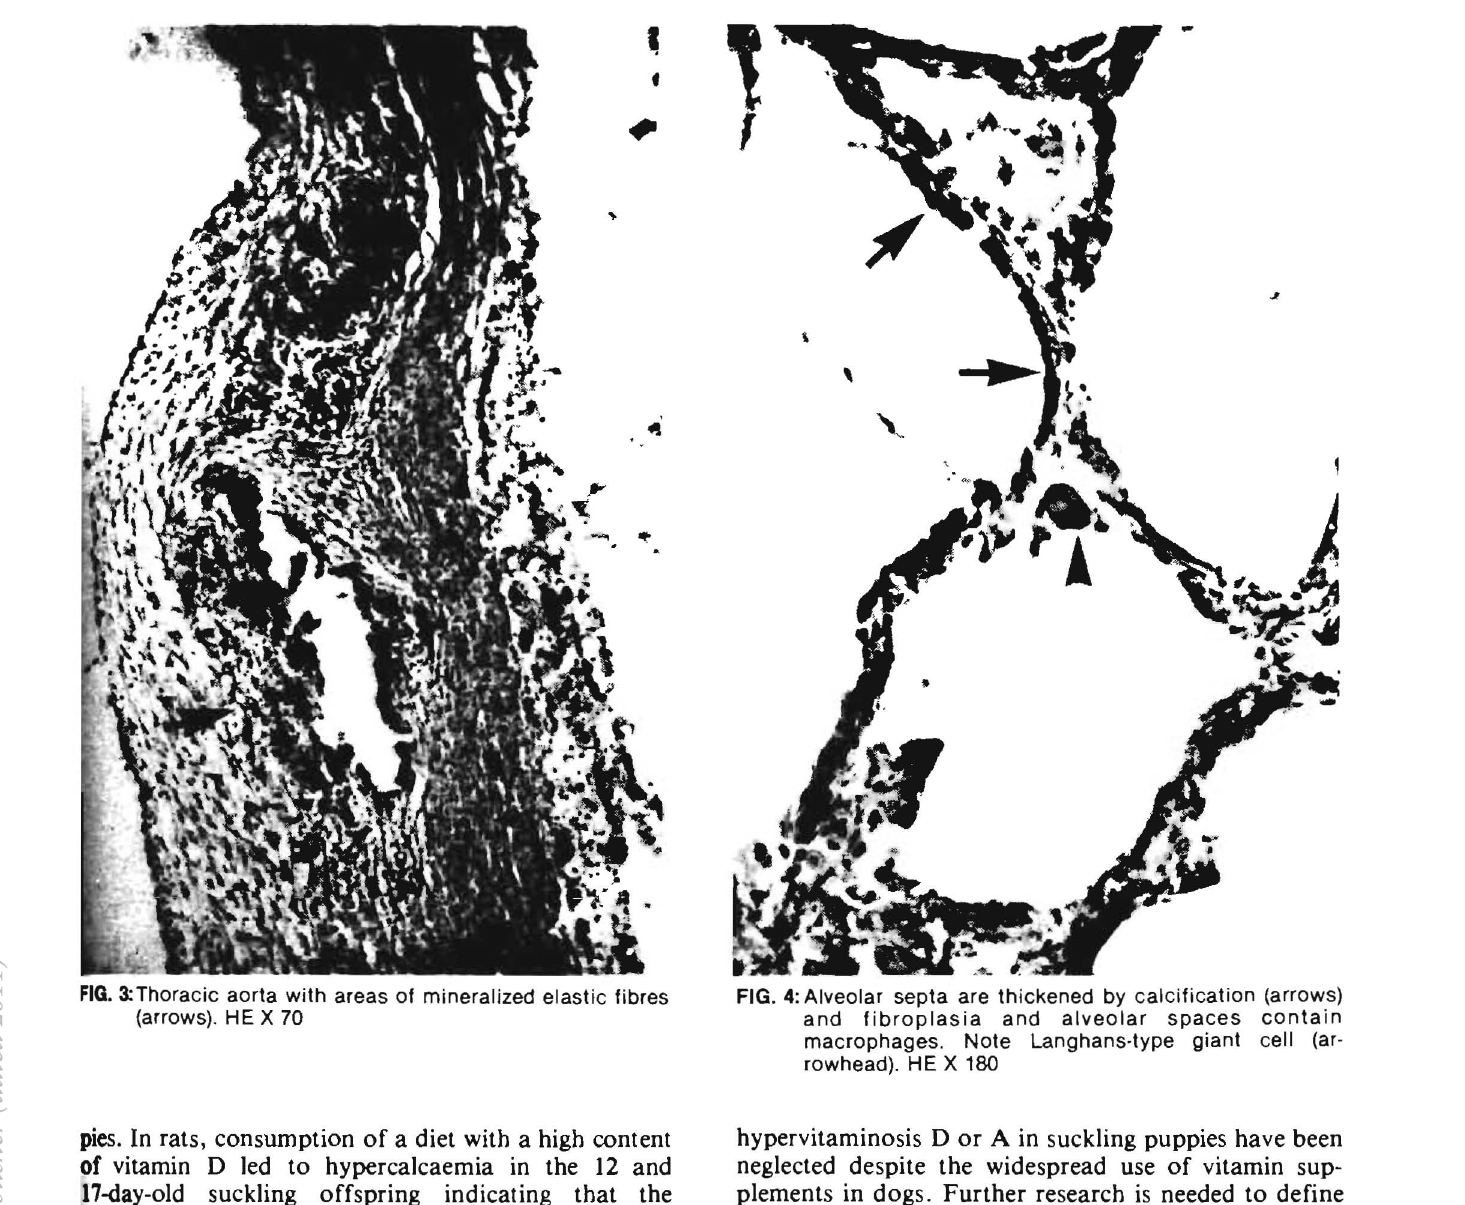
FIG. 4: Alveolar septa are thickened by calcification (arrows) and fibroplasia and alveolar spaces contain macrophages. Note Langhans·type giant cell (ar' rowhead). HE X